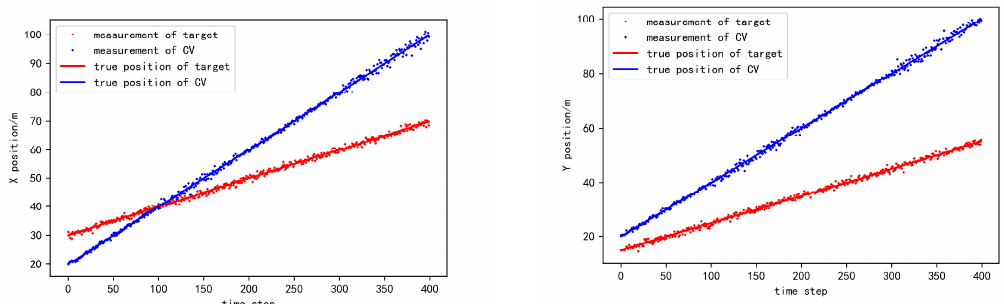
Figure 3. The position observation of the target and the cooperative vehicle in HV coordinate frame.